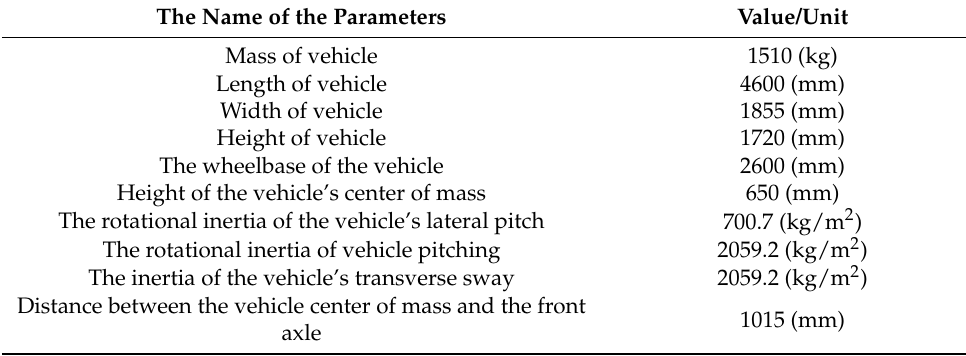
Table 5. Parameters of the vehicle.